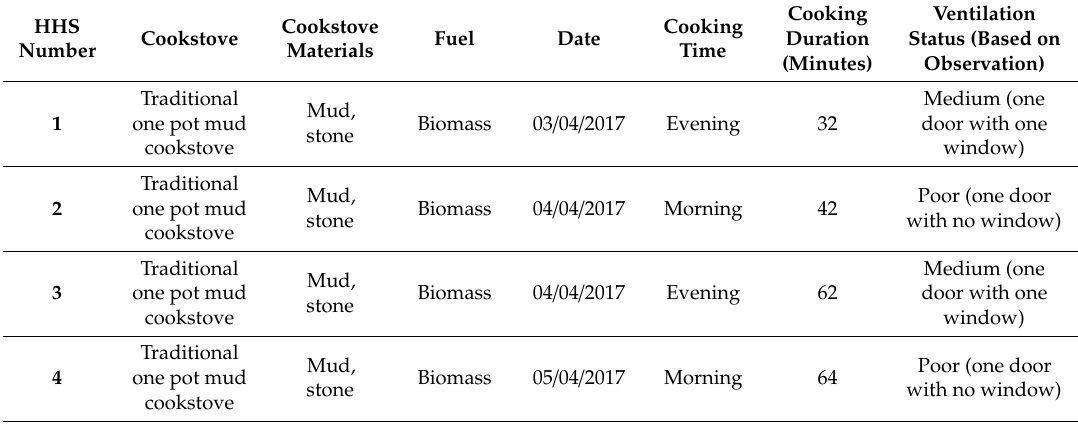
Table 1. Kitchen and fuel characteristics of the measured